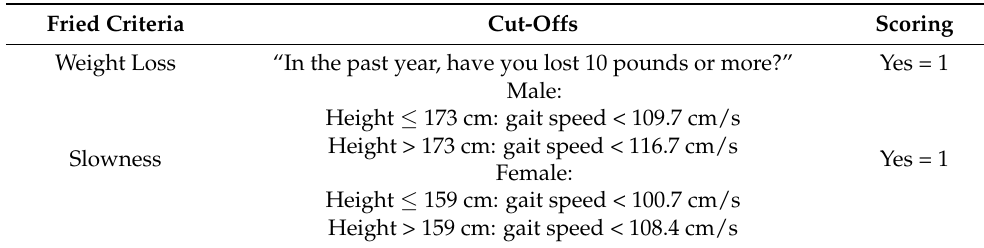
Table 1. Operationalisation of the frailty phenotype in TILDA. Fried